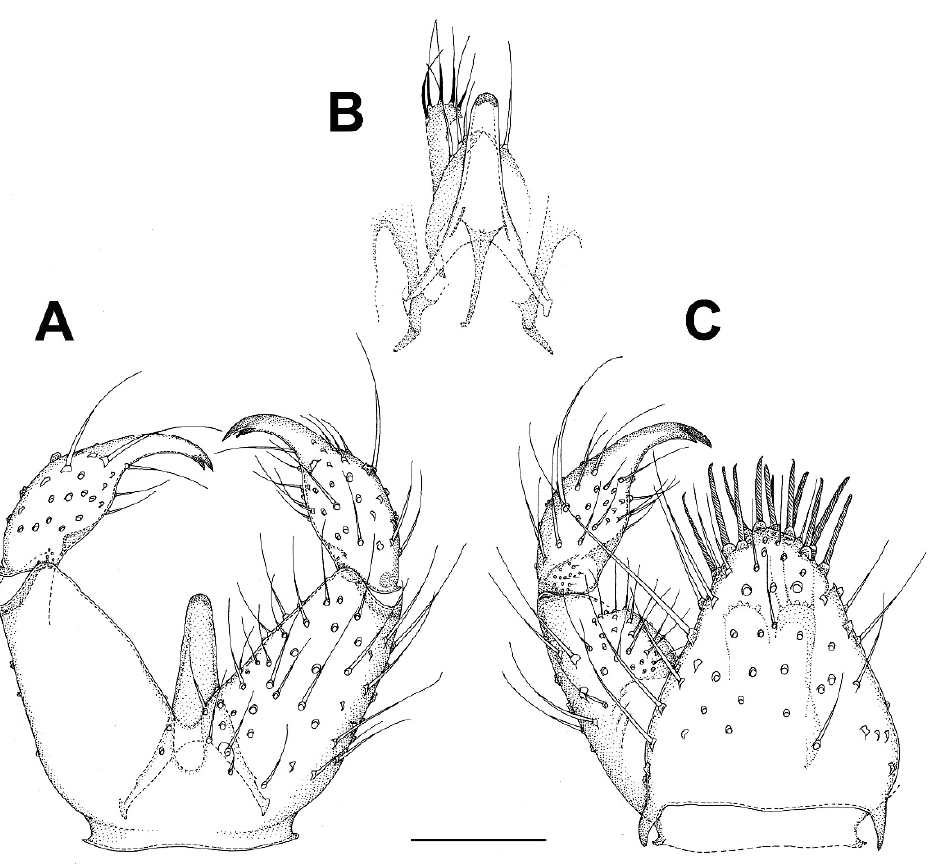
Figure 7. Male terminalia of Diadocidia pseudospinusola sp. nov. (holotype): ( A ) ventral view, ( B ) aedeagus, hypoproct and cerci in ventral view, ( C ) dorsal view.. Scale bar 0.1 mm.